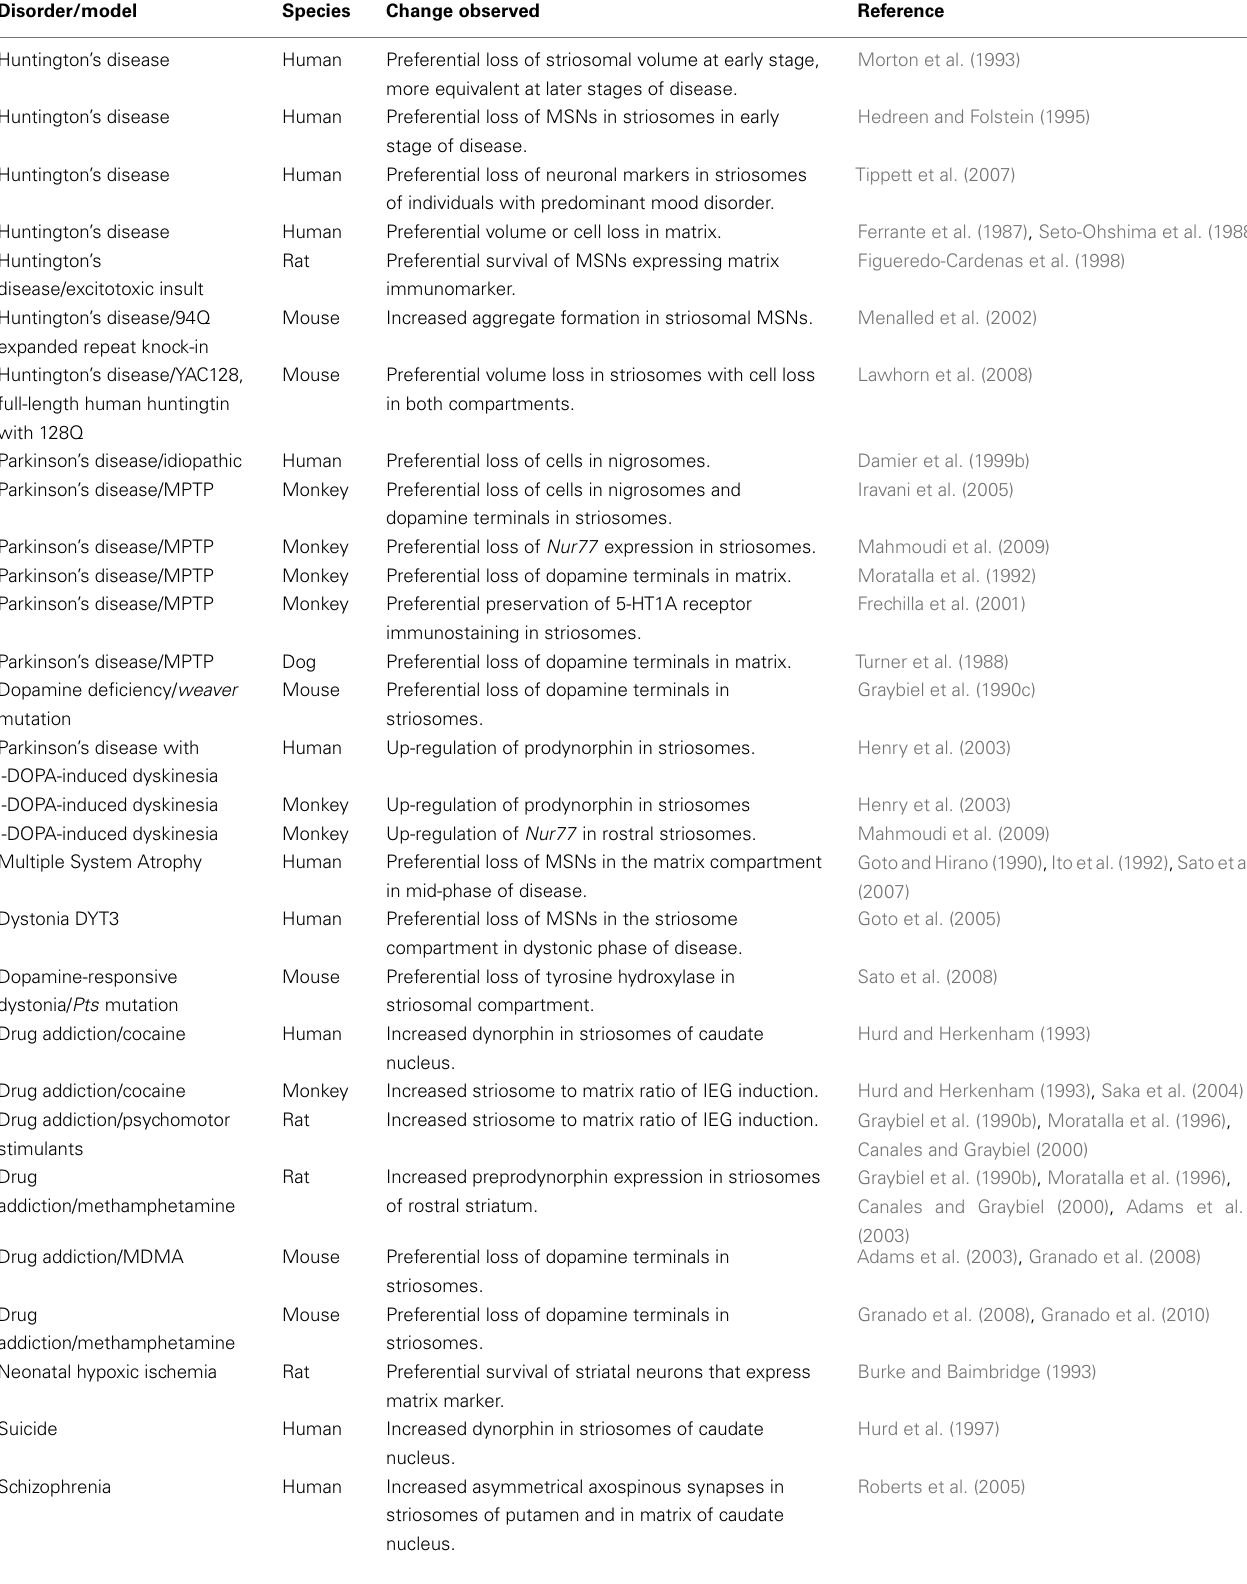
Table 2 | Diseases and disease models with disparate striosome vs. matrix